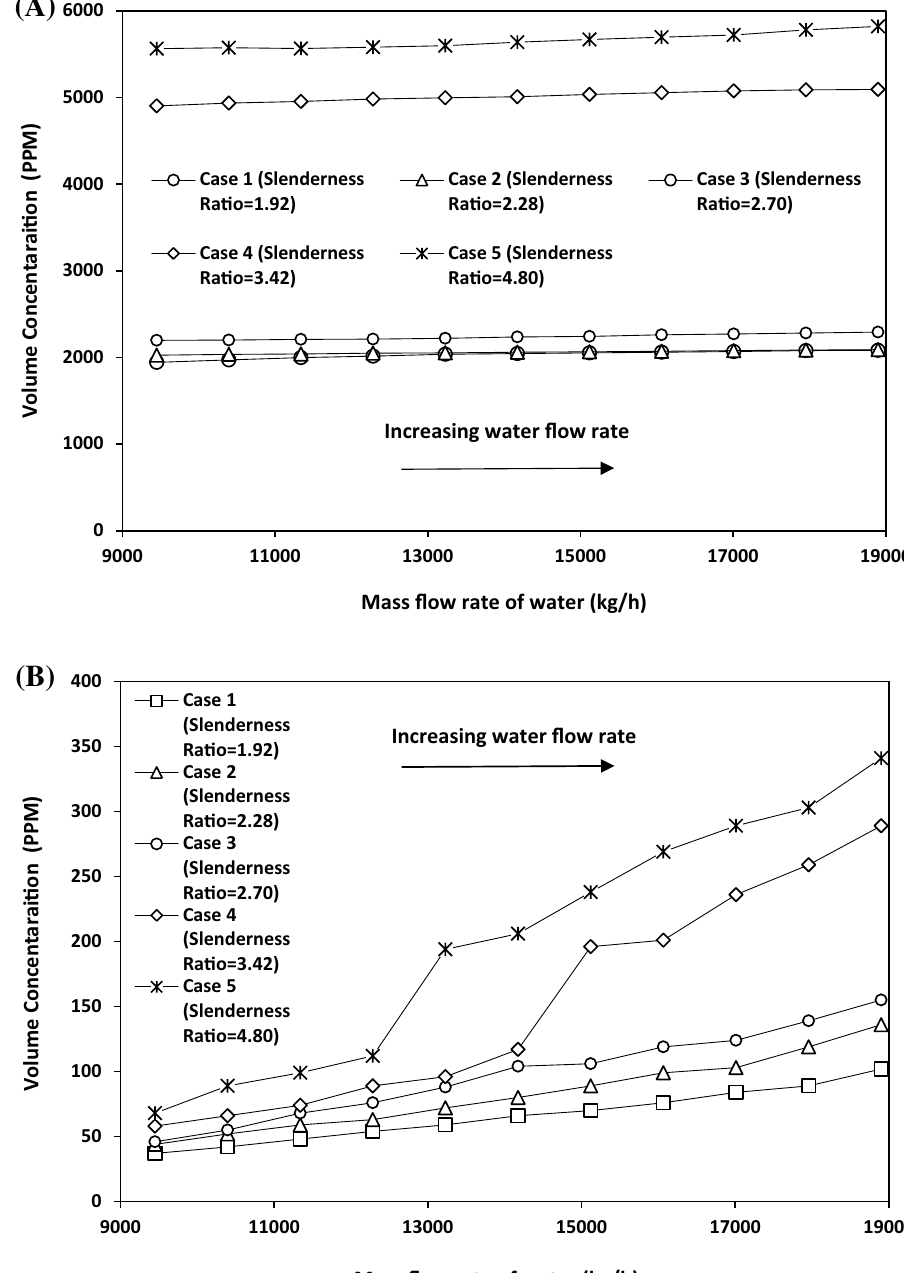
Fig. 19 Effect of input water rate on the amount of water in the condensate ( a ) and gas ( b ) outlets